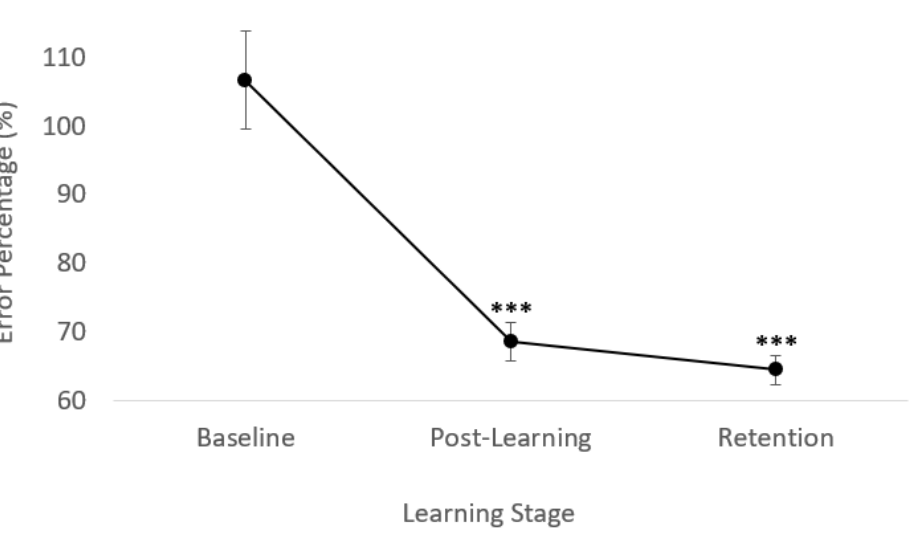
± SE. *** p < 0.0001 relative to